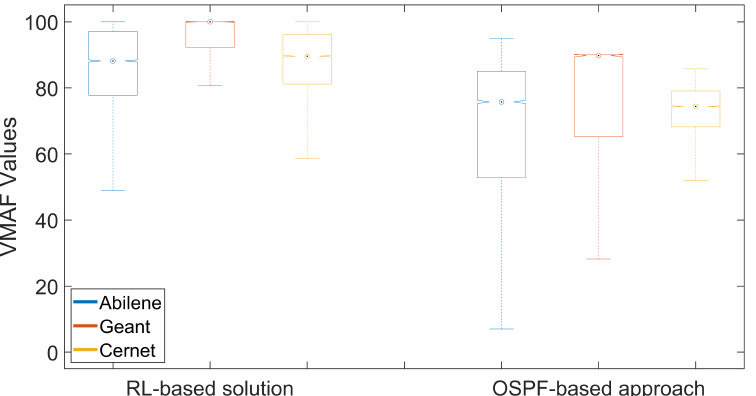
Figure 7. VMAF values for DASH video under high traffic loads in three different topologies.